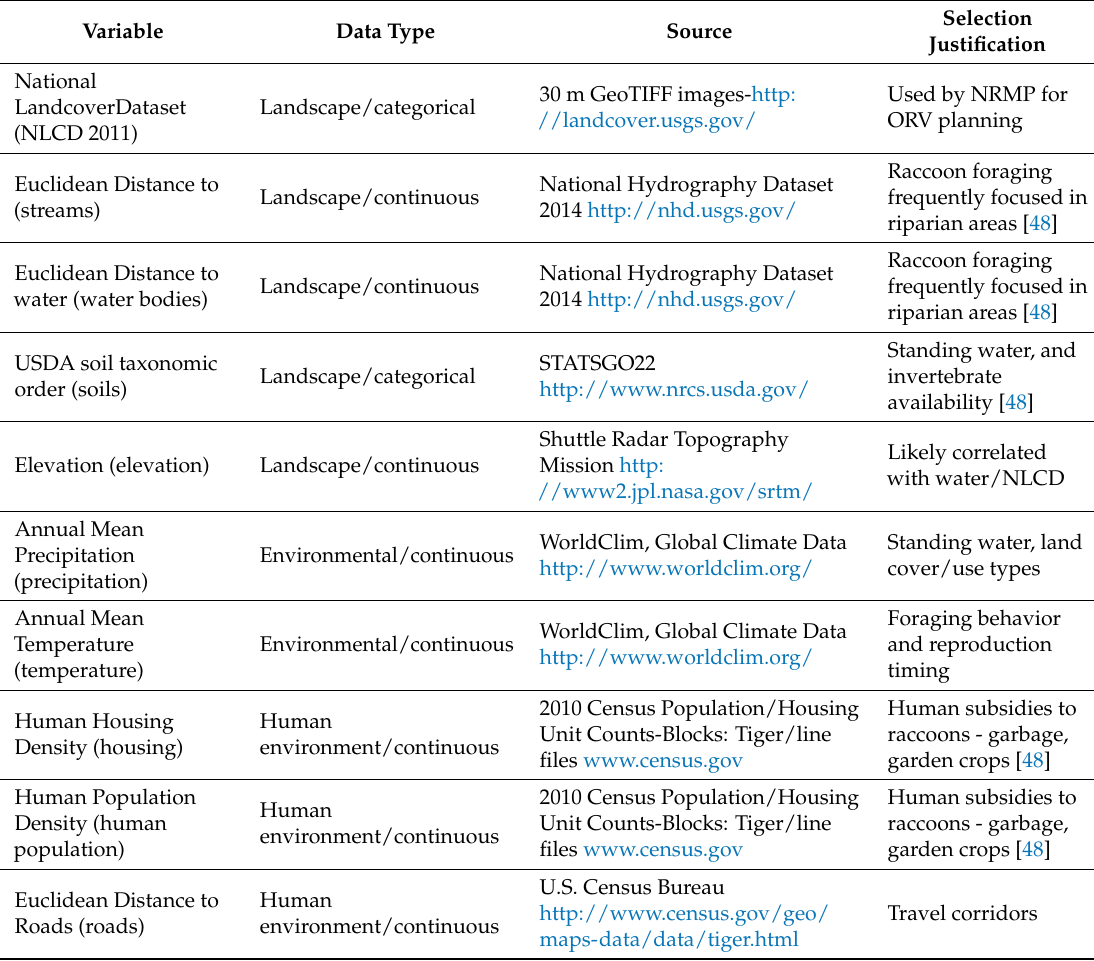
Table 3. Raccoon risk modeling: environmental variables, sources, and choice justification for pine-dominated landscapes of Massachusetts, Florida, and